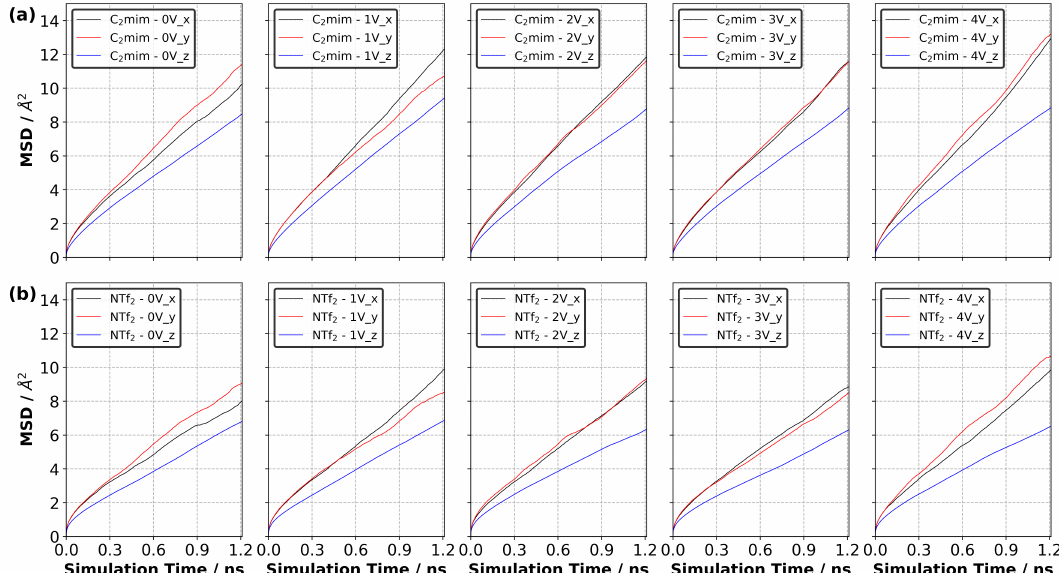
Figure 17. Calculated mean square displacement (MSD) at 294 K in each principal direction at each ∆Ψ value for ( a ) [C 2 mim] + and ( b ) [NTf 2 ] − (averaged over three independently generated